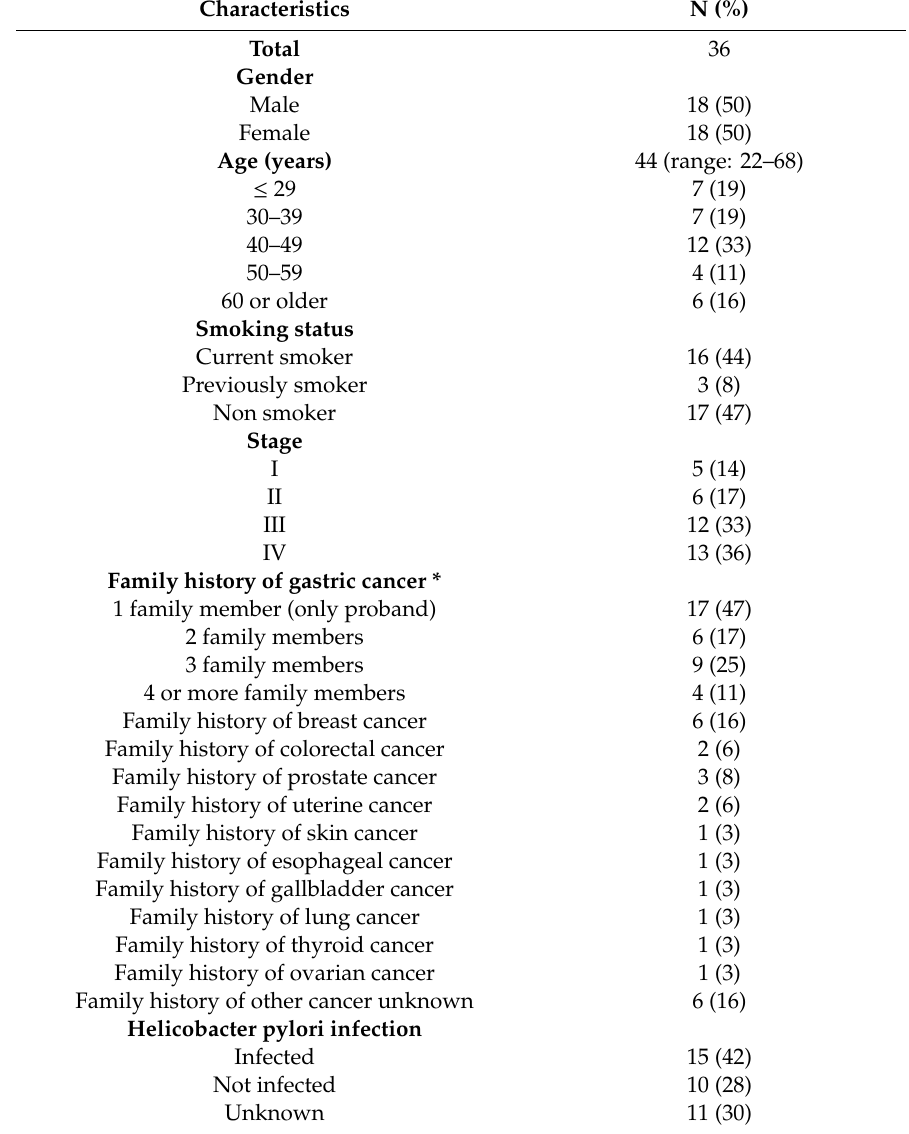
Table 1. Clinical characteristics of proband included in the